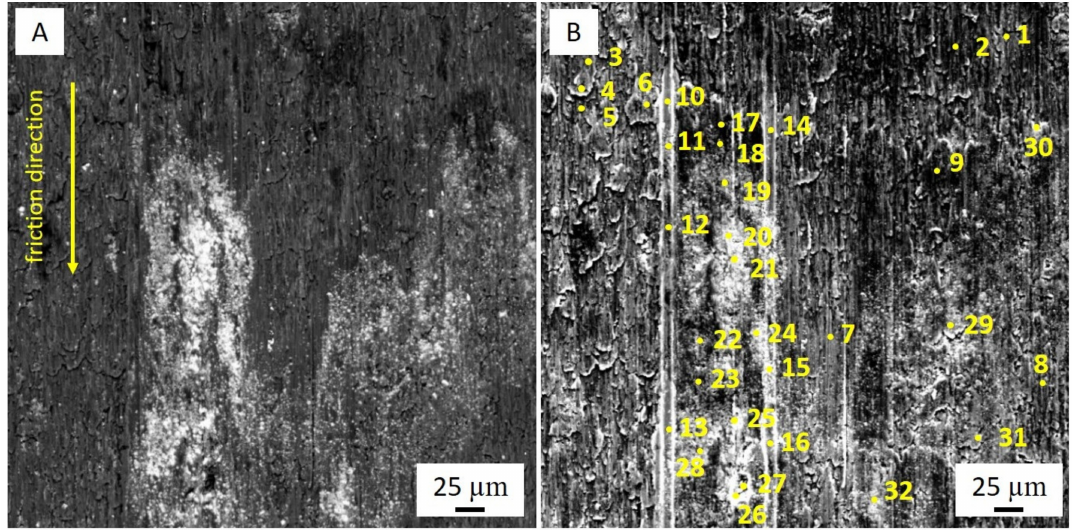
Figure 6. BSE ( A ) and SE ( B ) mode with EDS analysis points SEM images of the Al–Mo alloy after friction test. The elemental composition of the Al–Mo alloy friction surface was determined by EDS and presented in Table 9. Table 9. EDS chemical identification of elements and their concentration in Al–Mo alloy worn surface. Elements Composition,